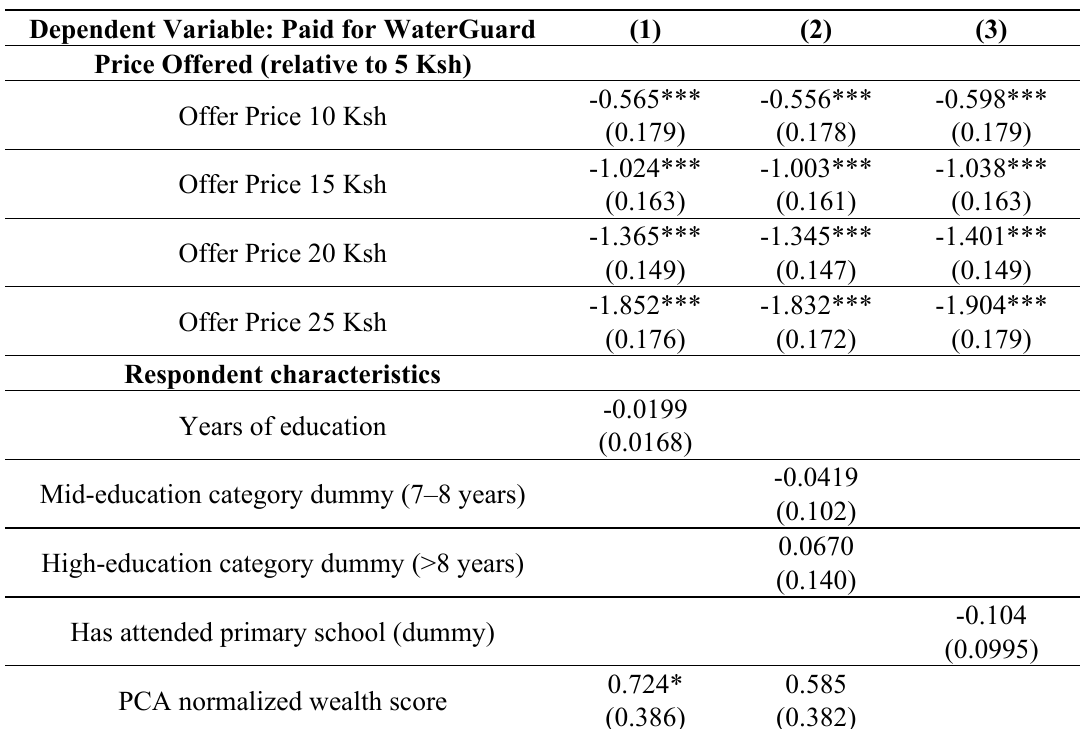
Table A2. Probit regression models for the purchase of WaterGuard: alternative education specifications (Models 1 and 2) and number of cell phones as a proxy for wealth (Model